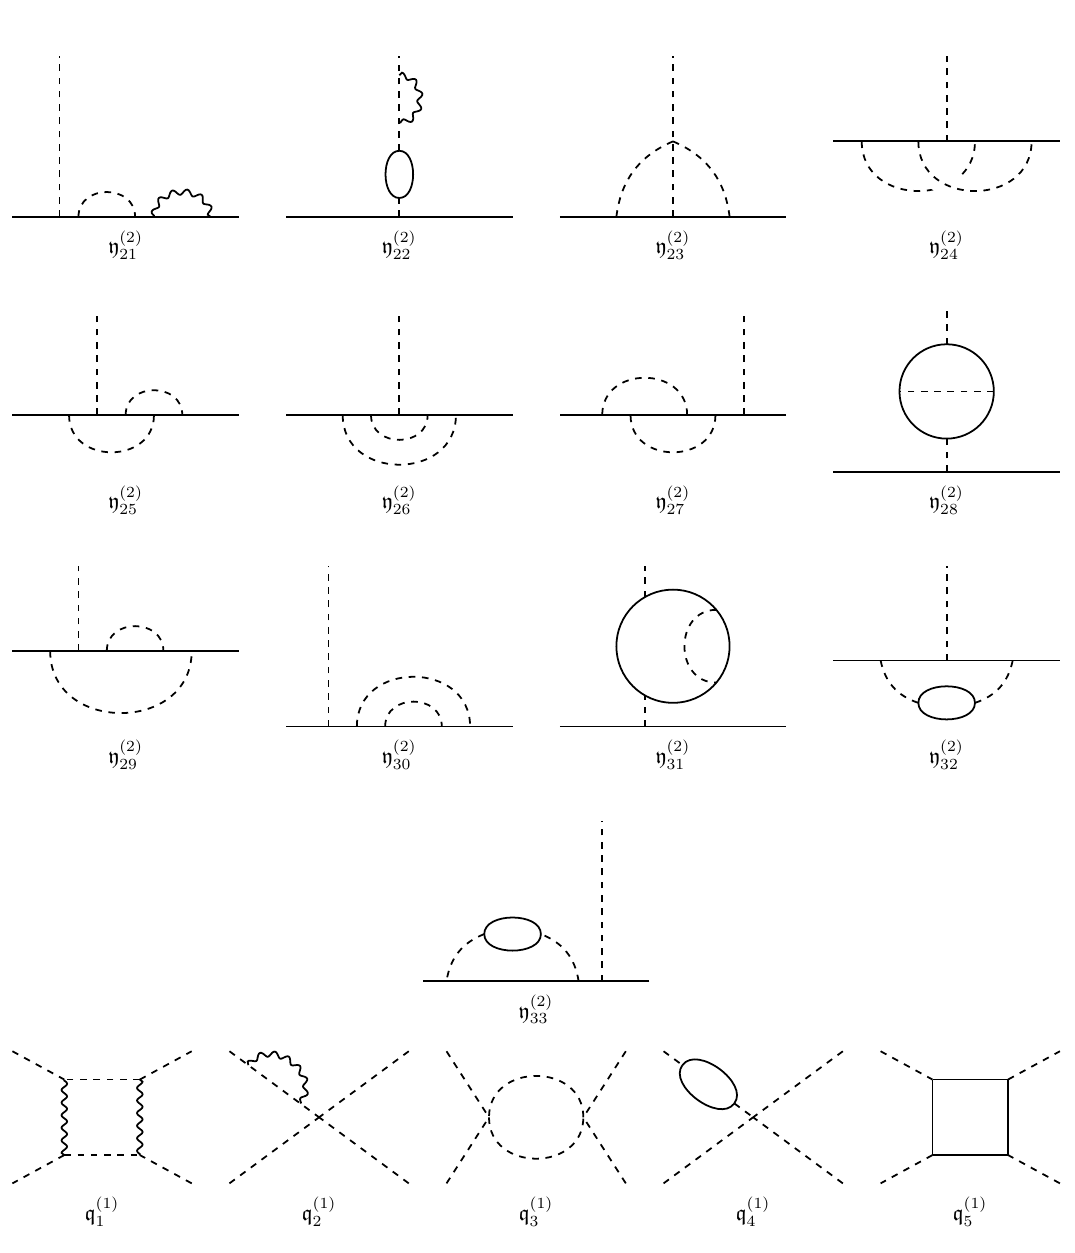
Figure 4 . (Continued) Graph representation of the TSs appearing in the Yukawa (cid:12) -function, (cid:12) ( ‘ ) at 2-loop order and the quartic (cid:12) -function, (cid:12) ( ‘ )